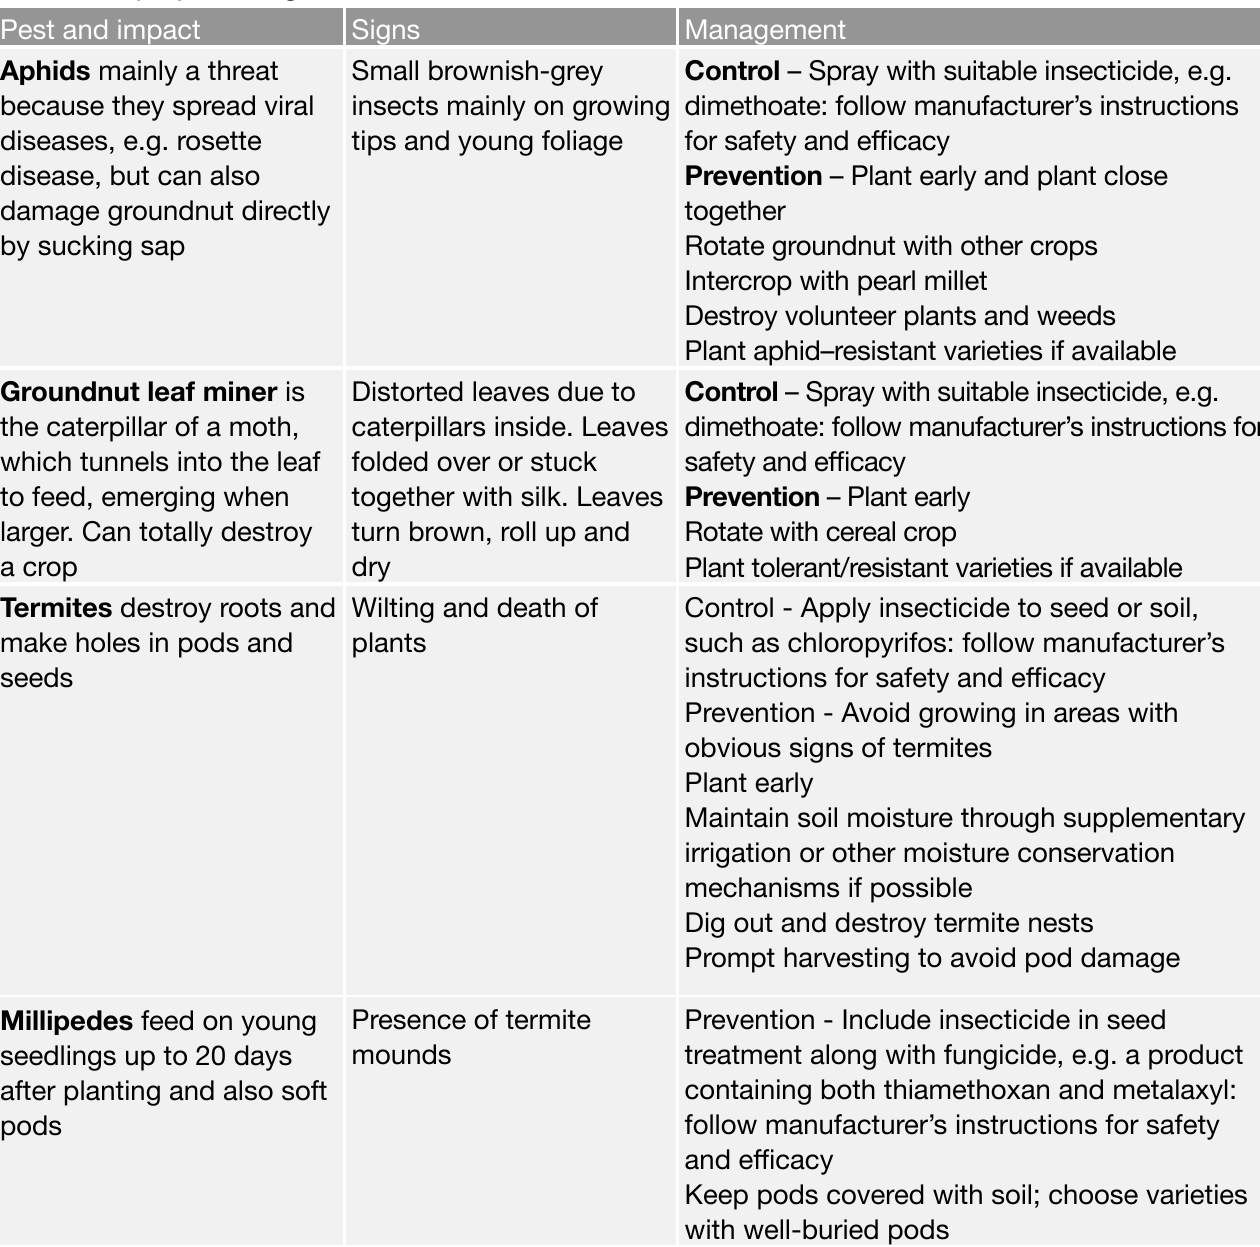
Table 3 summaries the impact, signs and management options for the main pests of groundnut. Table 3: Major pests of groundnut Pest and